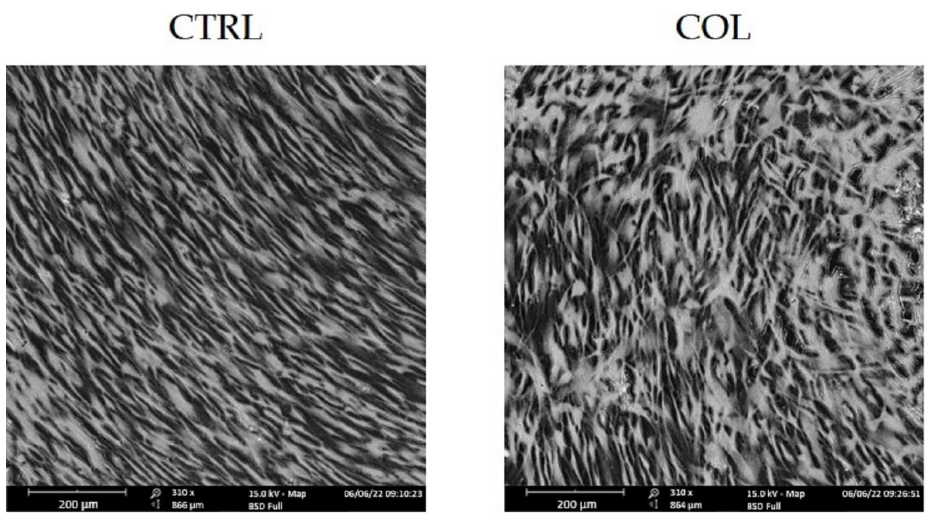
Figure 3. Representative SEM images of hGF cultured on uncoated (CTRL) and collagen-coated (COL) cell culture coverslips substrates. Magnification of 310x × Scale bar: 200 µ m.